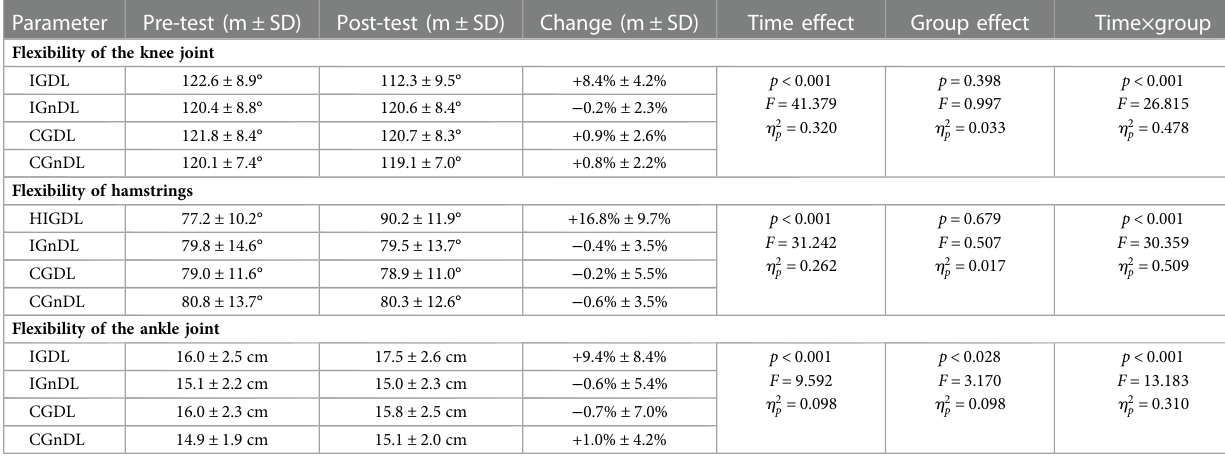
TABLE 4 Descriptive statistics and two-way ANOVA of fl